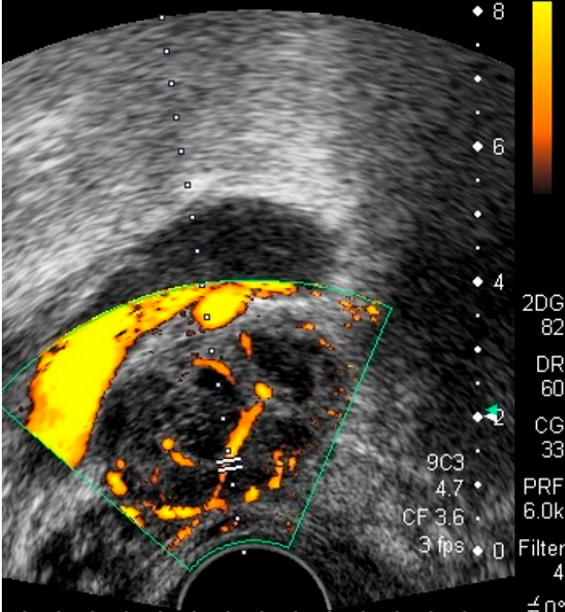
Figure 20. Transvaginal ultrasonography shows a septate cystic nodule independent from ovary corresponding to ovarian vein thrombosis. Power Doppler demonstrates peripheral and central vas- cularization.